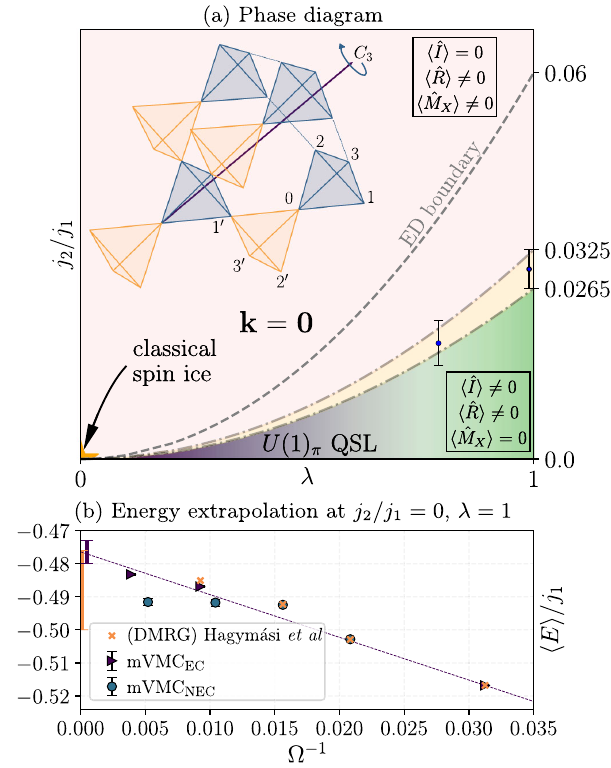
FIG. 1. (a) Pyrochlore Heisenberg λ − j 2 =j 1 phase diagram. The nonmagnetic phase (green) in the vicinity of (1,0) is separated by a phase transition (yellow) from the magnetically ordered k ¼ 0 phase (red). The U ð 1 Þ π QSL phase is shown in gray. Further indicated are the symmetry-breaking properties of ˆ I ˆ R the respective phases with respect to inversion ( ) and rotation ( ) symmetry. The ED phase boundary was obtained for a 4 × 2 3 system. Blue data points with error bars show our infinite-volume phase-boundary extrapolations at λ ¼ 0 . 8 and 1.0. Note that our data do not allow us to reliably draw conclusions about the shape of the phase boundary in the region λ ≪ 1 . The shape of the yellow region, shown in Fig. 1(a) at λ ≲ 0 . 8 , is a guide to the eye consistent with perturbative results for small λ . The inset in the upper left shows the pyrochlore structure with sublattice indices. (b) Best variational energies obtained within this work using mVMC on equilateral (EC) and nonequilateral (NEC) clusters at λ ¼ 1 , j =j 0 . The dashed line represents the infinite-volume 2 1 ¼ extrapolation. For comparison, the figure also shows the DMRG result of Ref. [38] without bond-dimension extrapolation. The error bars at Ω − 1 ¼ 0 represent the infinite-volume extrapolations obtained within this work and DMRG bond-dimension extrapo- lation of Ref. [38] (see main text for